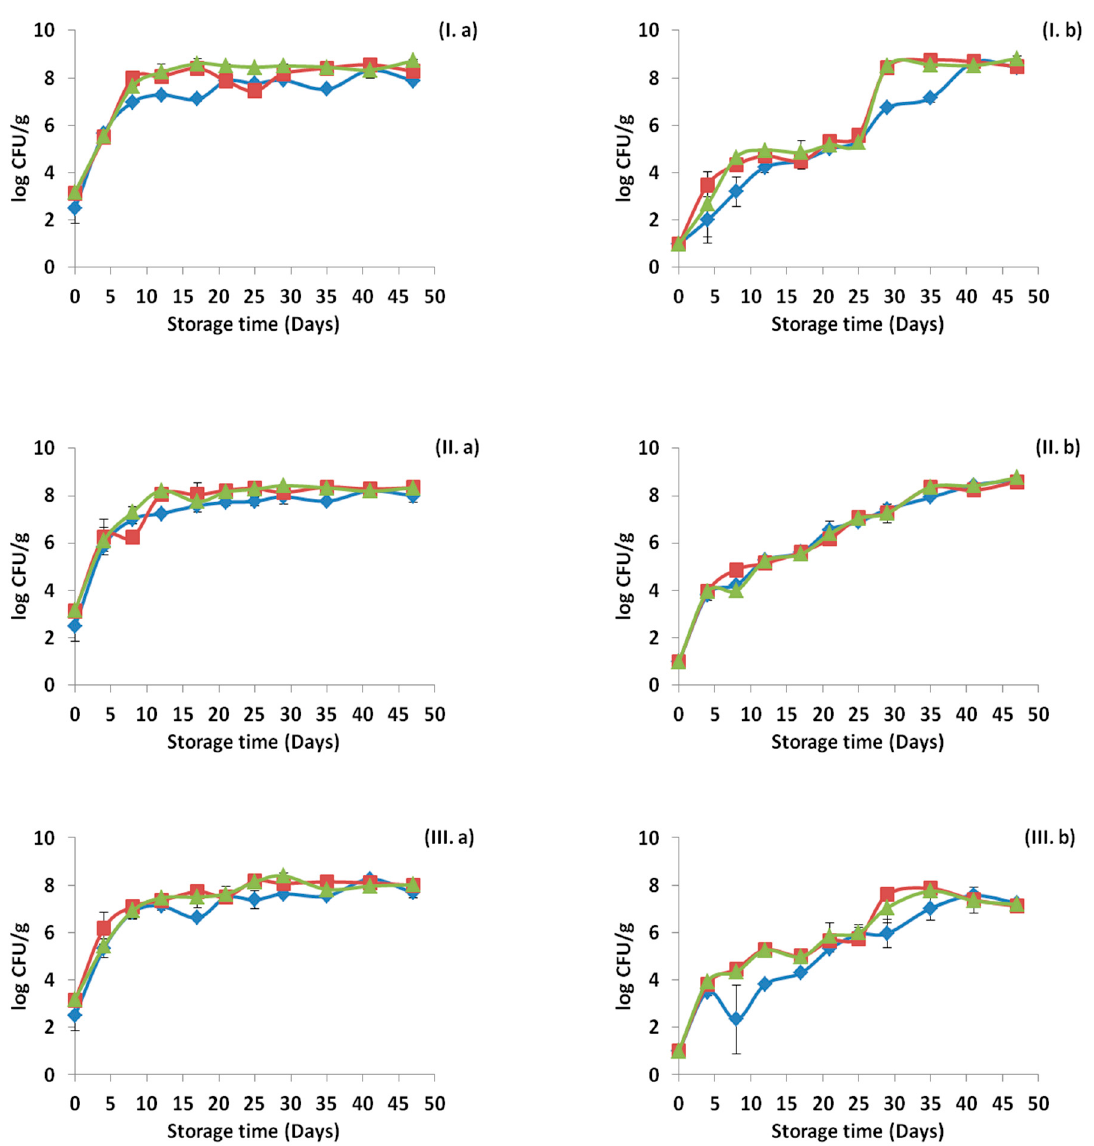
Figure 2. Growth curves of the different bacterial populations in ham stored at 8 °C for the control samples ( I ), samples with edible film free from oregano essential oil-OEOF ( II ) and samples with edible film supplemented with oregano essential oil-OEOS ( III ), without ( a ) and after ( b ) the high pressure processing treatment. ( ♦ ) Lactic acid bacteria, ( ■ ) lactococci/streptococci and ( ▲ ) total viable counts. The bars represent the mean values ± standard deviations.